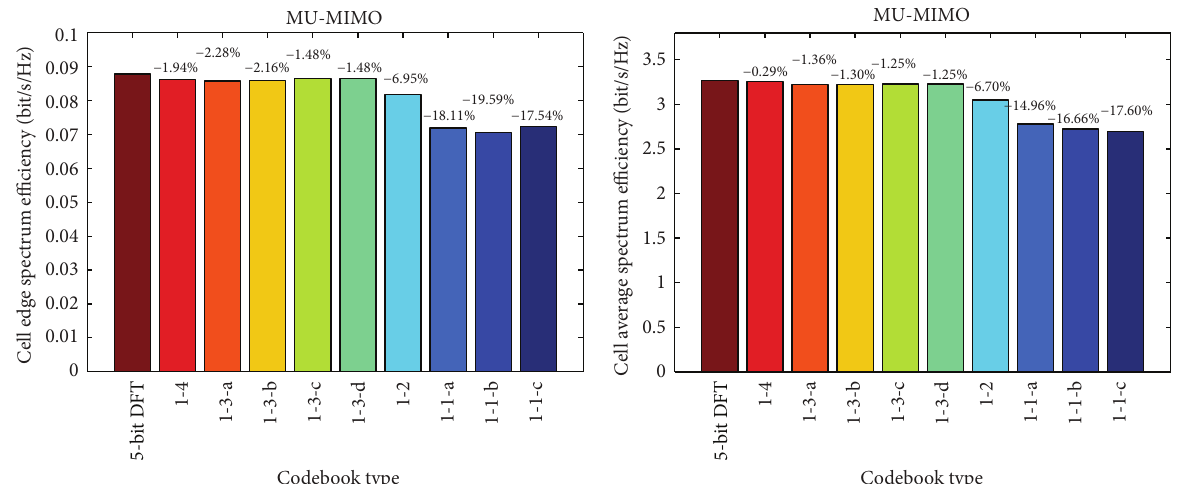
Figure 8: Simulation results of the codebooks for the vertical domain under 3D-UMa